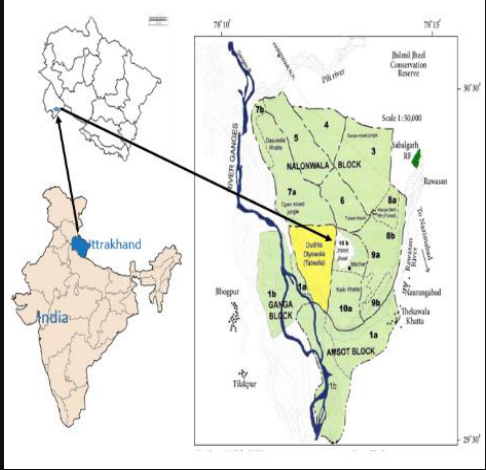
Figure 3 – Location of JhilmilJheel Conservation Reserve, Uttarakhand, India (Annonymous,